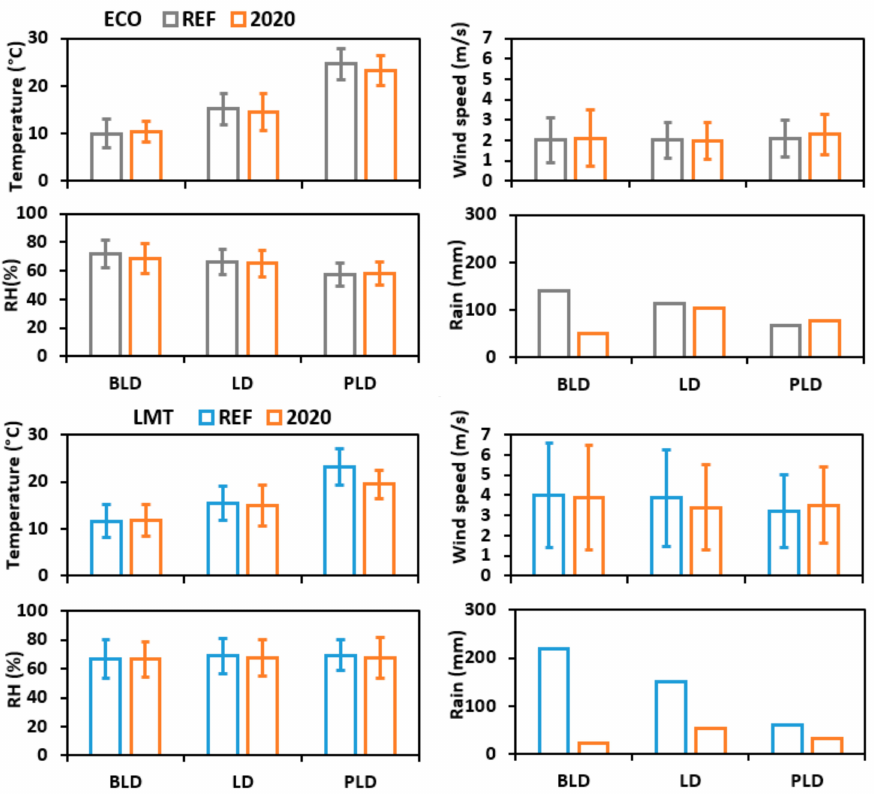
Figure 6. Average values of temperature, relative humidity, wind speed and rain accumulation, measured during the three periods (before lockdown (BLD), lockdown (LD) and postlockdown (PLD)) of 2020 and reference (2015–2019) years.